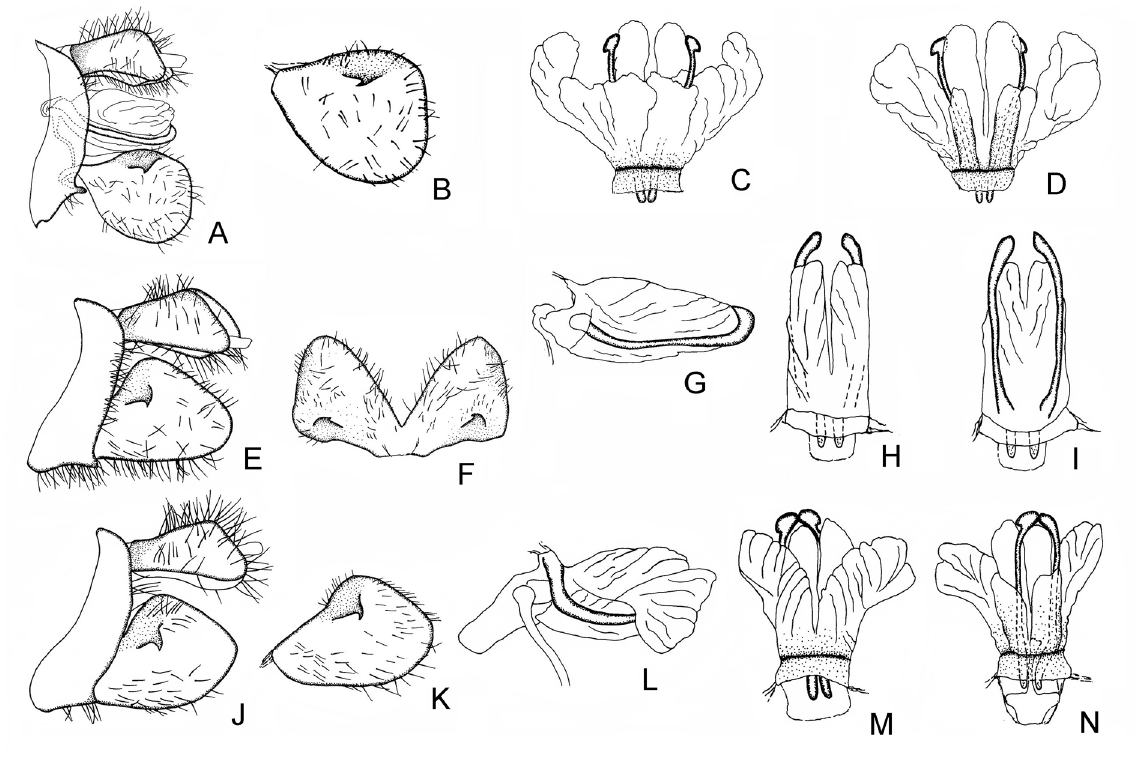
Fig. 15. Male genitalia. A – D . Limois sordida sp. nov., Shanxi, Ningwu, Mt. Luyashan, Ai-ping